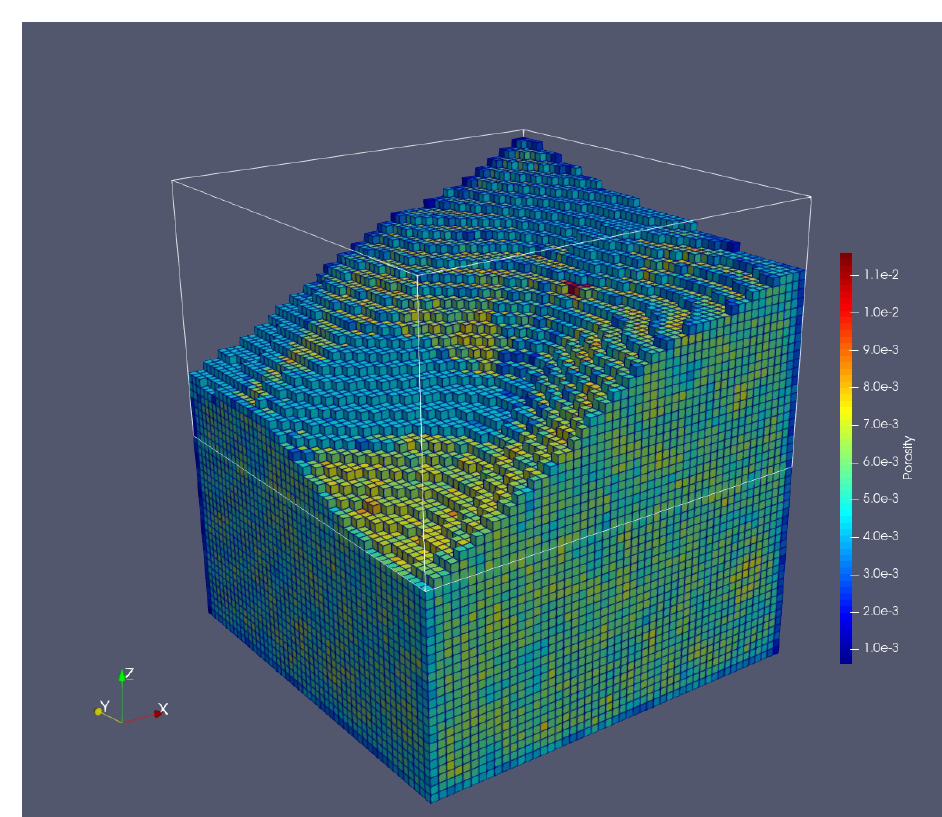
Figure 4. Numerical model domain of the granitoid shown with grid cells, looking from the southwest toward the northeast. Granitoid coloring is based on porosity determined from upscaling the DFN. Dimensions are 2.5 km × 2.5 km in the horizontal directions and 2.75 km in the vertical